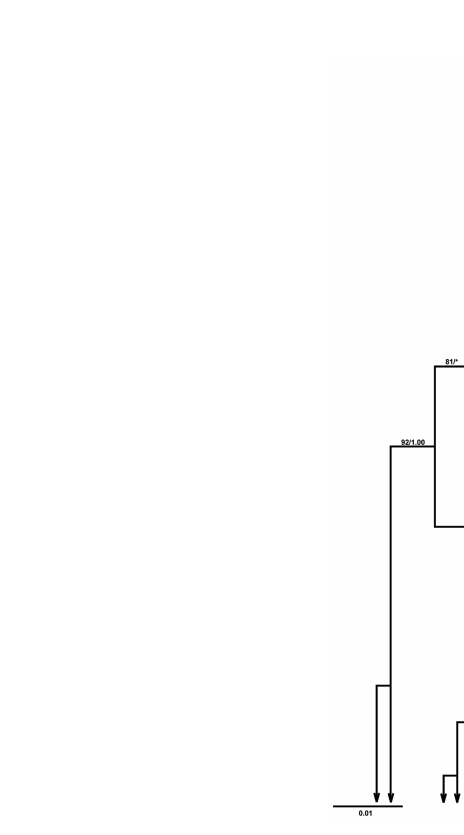
FIGURE 1 Phylogenetic tree of four new species of Trichoderma identi fi ed by Gu et al. (2020) based on Maximum Likelihood analysis of a combined ITS, RPB2, and TEF1 a sequence data